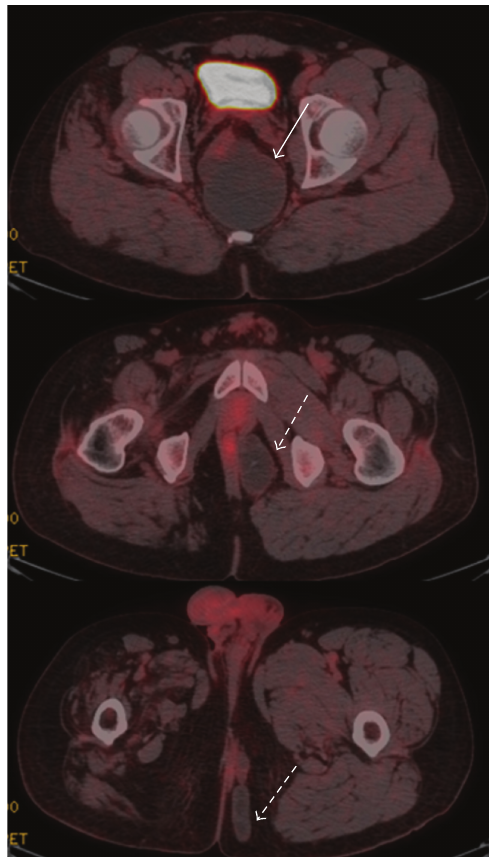
Figure 2: Fused FDG PET/CT images show no FDG uptake in the known retrorectal tailgut cyst (solid arrow) or the left ischioanal and perineal subcutaneous hydatid cysts (dashed